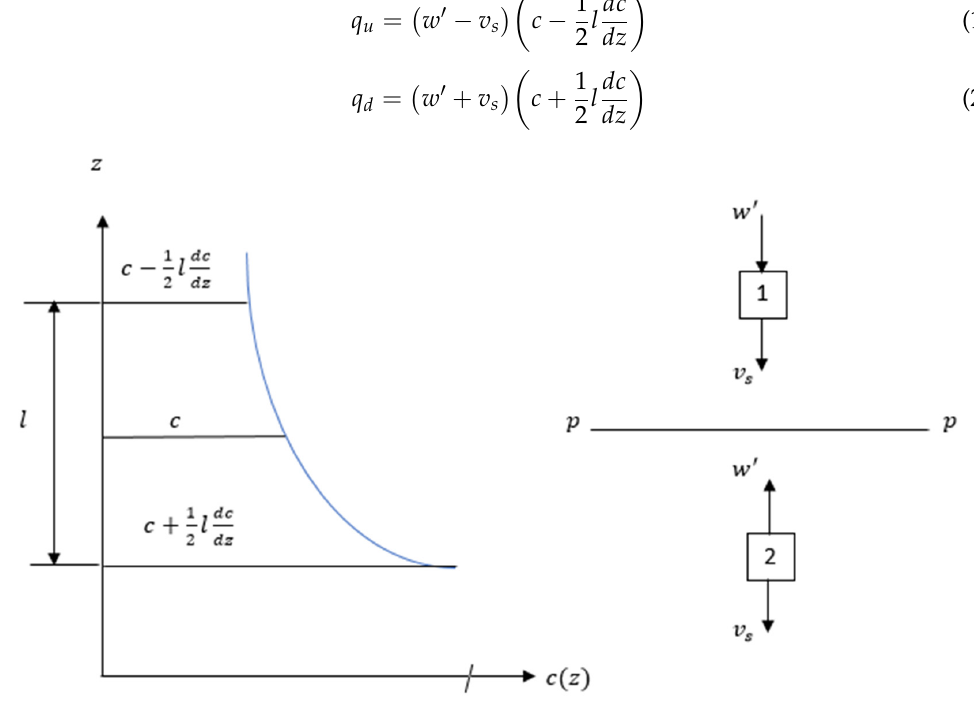
Figure 1. Suspended sediment concentration profile as governed by flow turbulence.